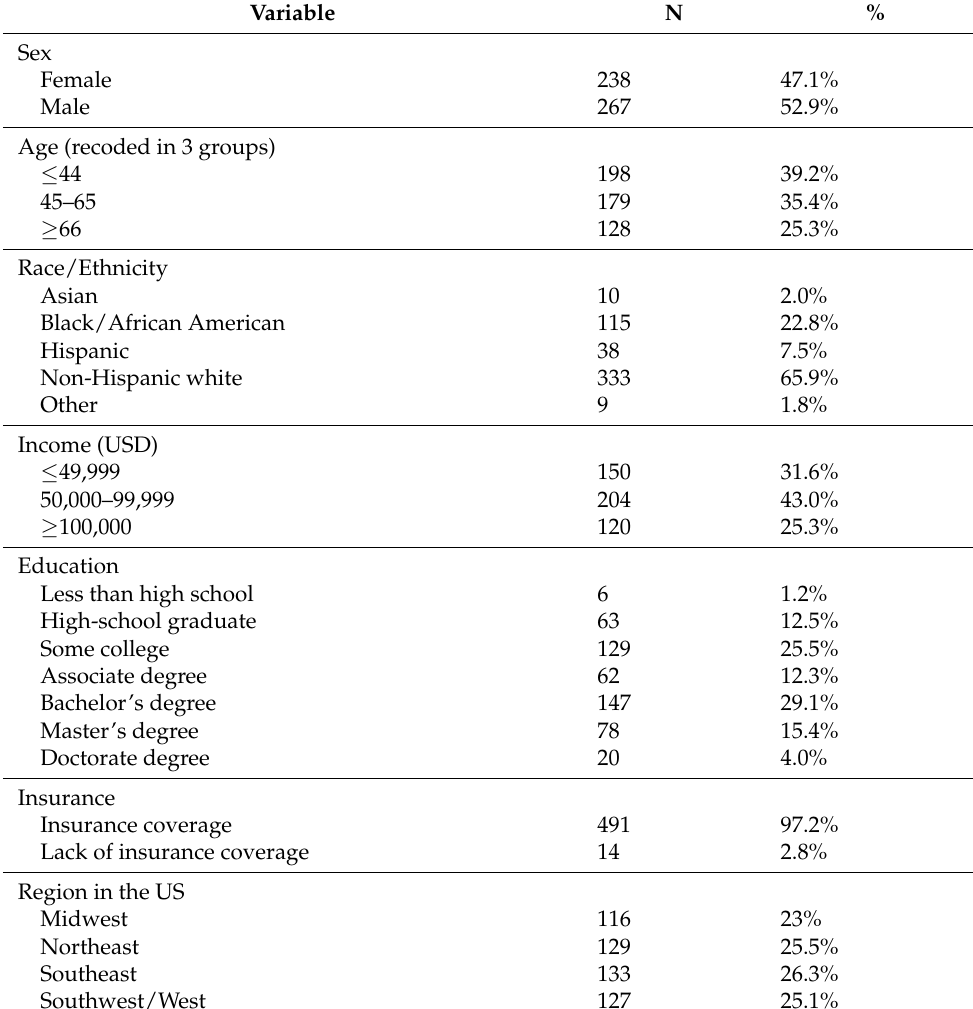
Table 1. Sociodemographic and clinical characteristics of the sample (N = 505). Variable